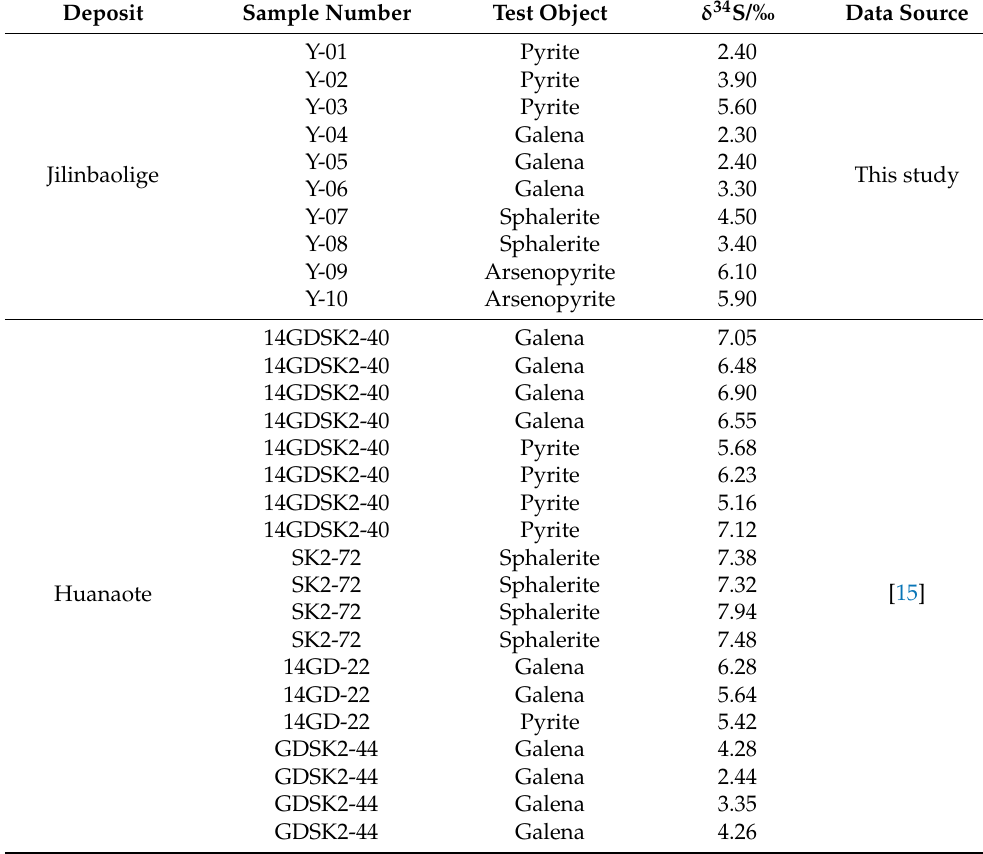
Table 5. Sulfur isotopic compositions of the sulfides in the Jilinbaolige deposit and the polymetallic deposits in the Great Xing’an